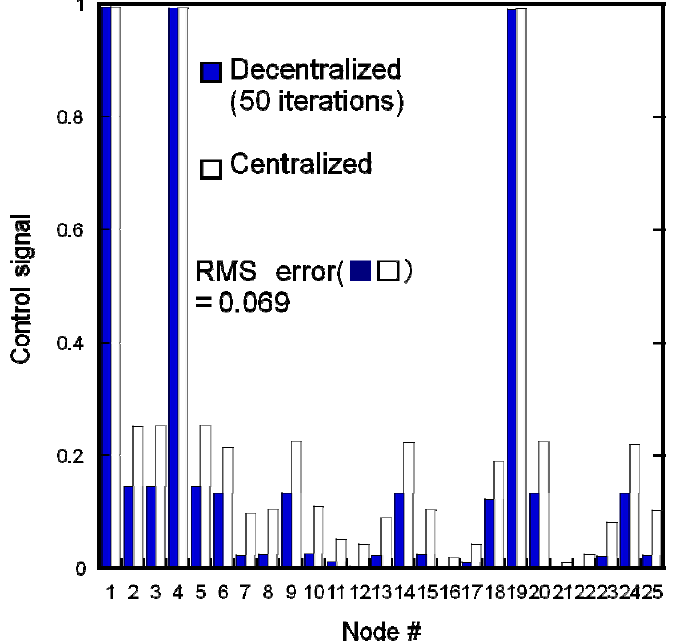
Figure 7. Experimental results of distributed actuation using simulations of centralized and decentralized algorithms. The decentralized algorithm is based on the penalty function method.